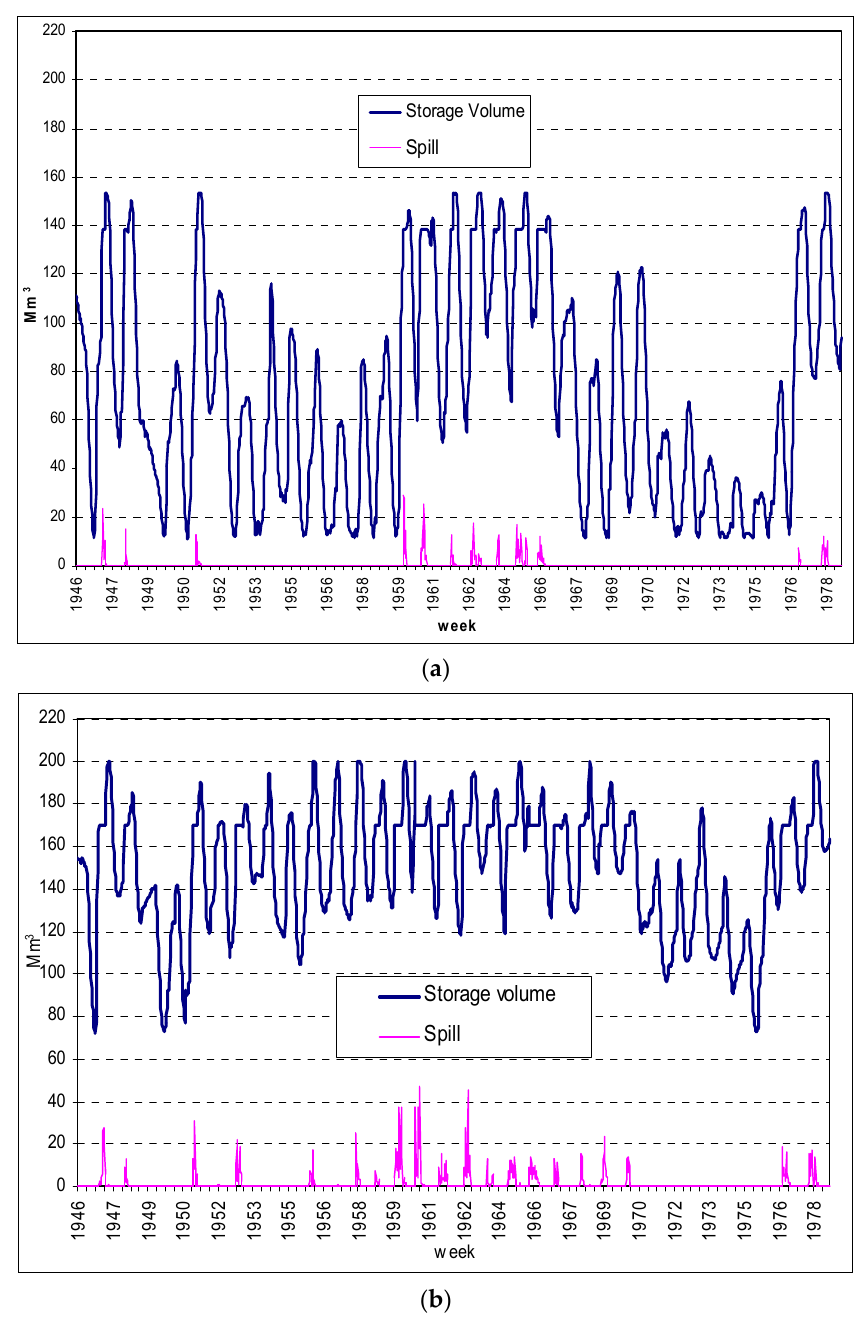
Figure 4. ( a ) Montedoglio Reservoir, volume stored and spills; ( b ) Casanova Reservoir, volume stored and spills.